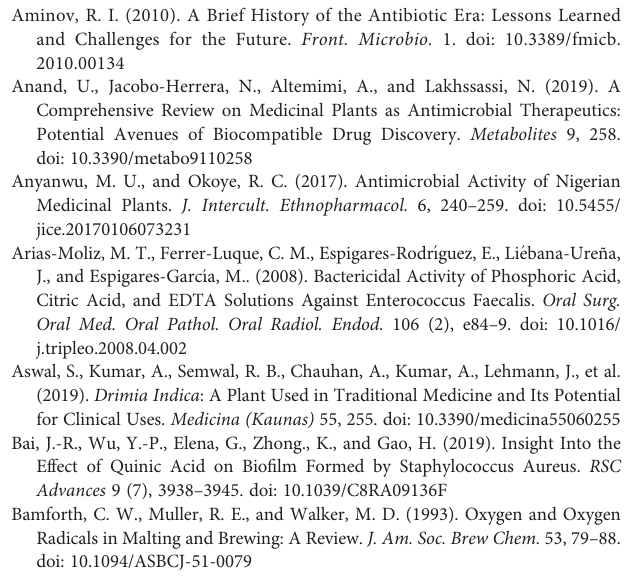
Supplementary Figure 1 | | Calibration curve of Gallic acid (A) , Quercetin (B) and Ascorbic acid (C) . Supplementary Figure 2 | | Pearson ’ s correlation coef fi cient (r) test among TPC, TFC, TAA, DPPH, ABTS, nitric oxide radicals scavenging activity, and Iron chelating activity. Correlation coef fi cients are indicated by the color (Red: positive correlation; blue: negative correlation). TPC = total phneol content, TFC = total fl avonoid content, TAA = total antioxidant activity, NO = nitric oxide inhibition, IC = iron chelation. Supplementary Figure 3 | | Summary of linear correlation between binding af fi nity of DdlA and MAPK1 in terms of